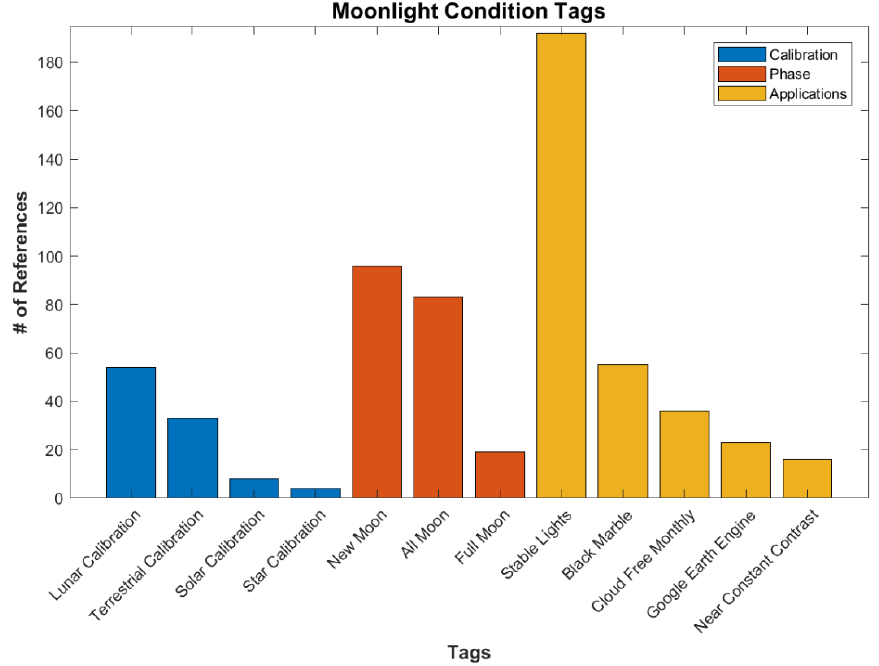
Figure 19. Different tags showing moonlight conditions per number of